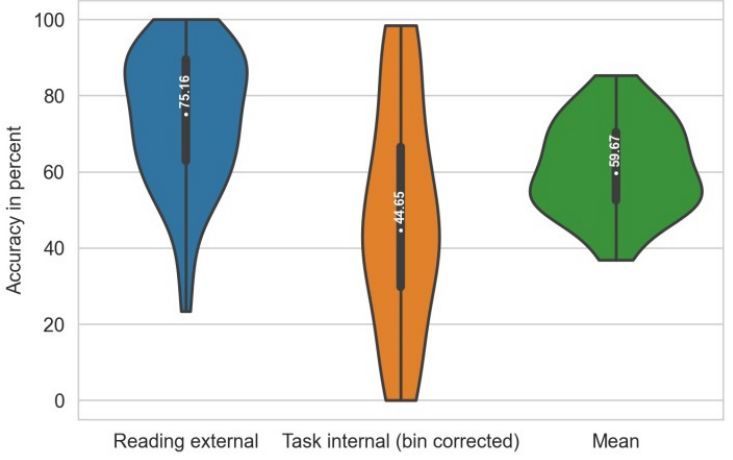
Figure 7. Prediction accuracies for reading (external), task-oriented internal attention and their mean. Indicating the mean, standard deviation and distribution over participants. and mean of